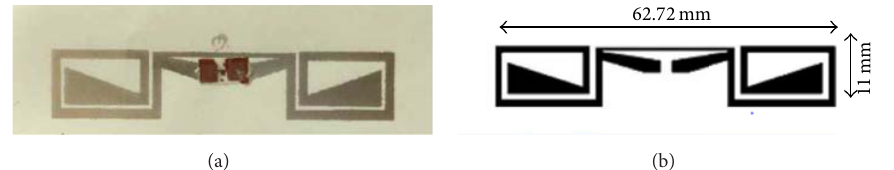
Figure 5: (a) A ready inkjet-printed UHF RFID tag on Paper B. (b) The utilized tag antenna